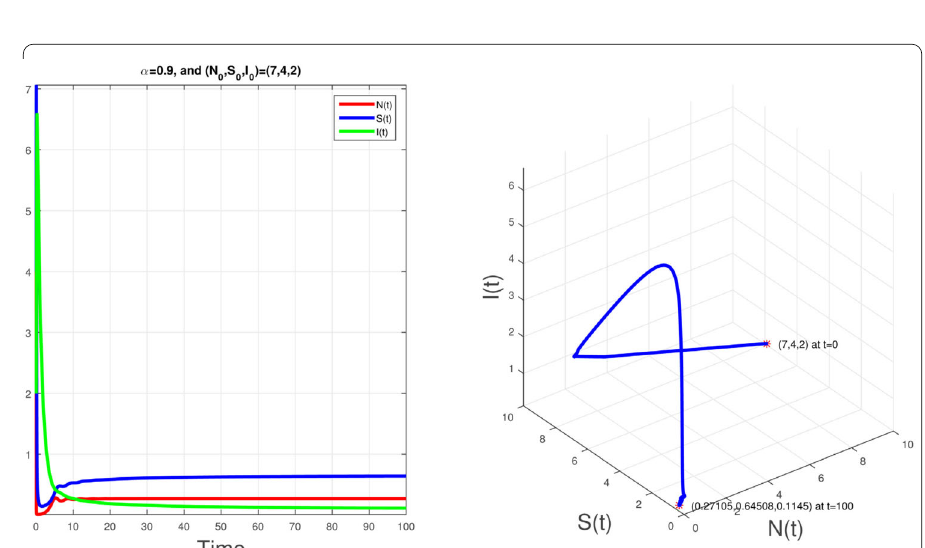
Fig. 7: We consider the values α = 0.9 , r = 5.2 , k = 30.5 , μ = 2.5 , e = 0.8 , λ = 1.5 , a = 0.5 , β = 3.5 , η = 0.5 are utilized. Fig. 8: We put α = 0.9 , r = 5.2 , k = 30.5 , λ = 4.5 , μ = 2.5 , e = 0.8 , a = 0.5 , β = 3.5 , η = 0.5 . Fig. 9: We set α = 0.9 , r = 5.2 , k = 30.5 , μ = 2.5 , e = 0.8 , a = 0.5 , β = 3.5 , η = 0.5 , and multi-values of λ . Fig. 10: We use the following set of the parameters: α = 0.9 , r = 5.2 , k = 30.5 , μ = 2.5 , e = 0.8 , λ = 0.2 , β = 3.5 , η = 0.5 , and multi-values of a . Fig. 11: We use the following set of the parameters: r = 5.2 , k = 30.5 , μ = 2.5 , e = 0.8 , a = 1.5 , λ = 0.1 , β = 3.5 , η = 0.5 , and multi-values of α